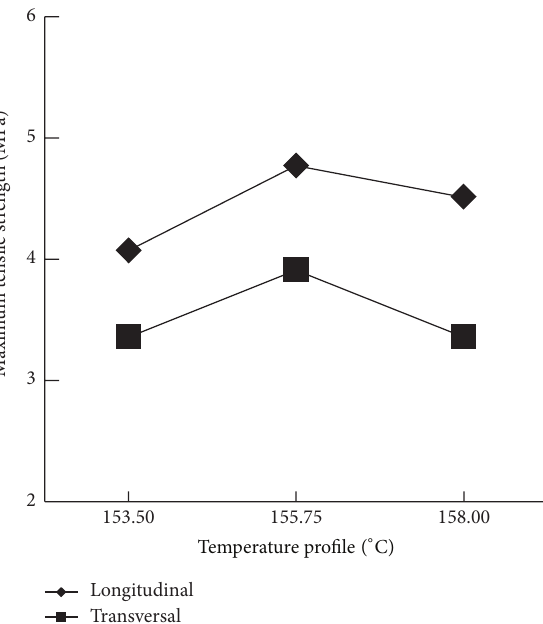
Figure 3: Behavior of maximum tensile strength against the tem- perature